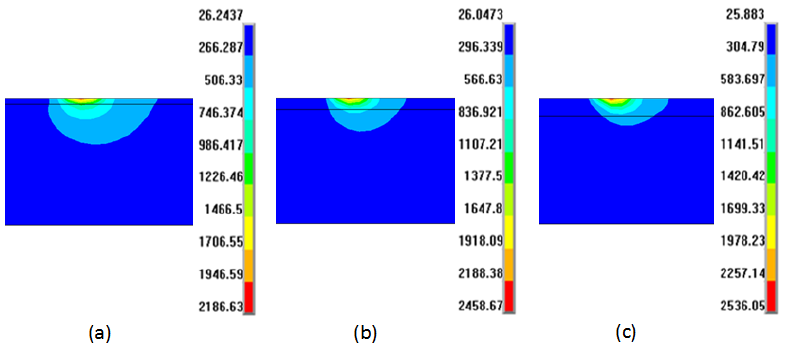
Figure 3. Temperature field clouds of different thicknesses: ( a ) temperature field of 0.5 mm for the melting layer; ( b ) temperature field for a 1 mm cladding layer; ( c ) temperature field of 1.5 mm for the cladding layer.